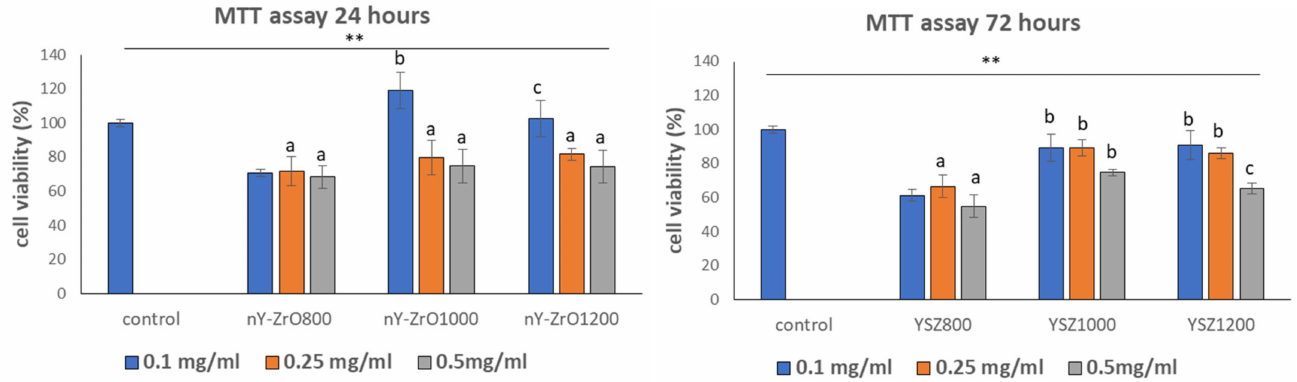
Figure 5. MTT results of cell viability at different concentrations (0.1, 0.25, 0.5 mg/mL) of yttria stabilized zirconia nanofillers. ** Indicates statistically significant difference ( p < 0.001) between treated and untreated cells without nanoparticles (control), while different letters suggest statistically significant differences ( p < 0.001) among